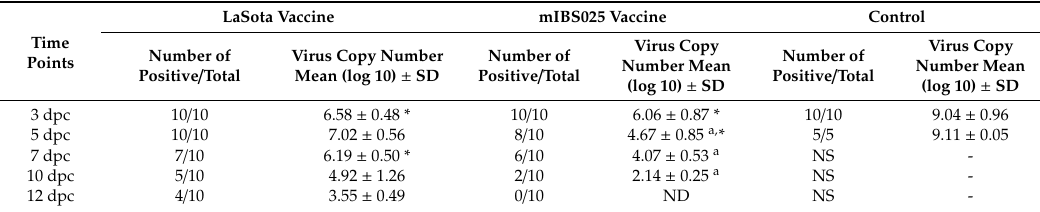
Table 6. Oropharyngeal virus shedding among vaccinated and non-vaccinated birds at di ff erent time points post